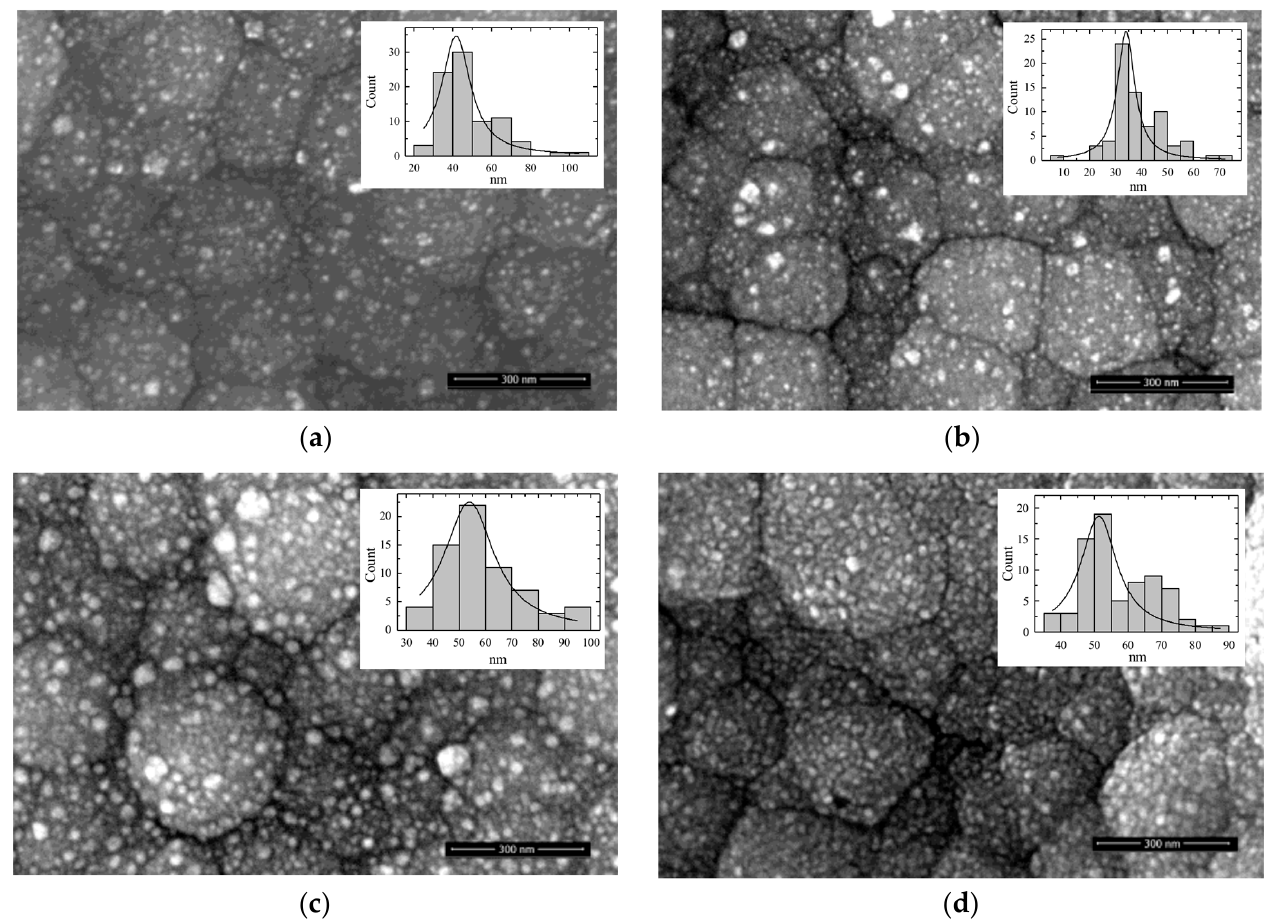
Figure 2. The surface morphology of: ( a – c ) AuNi-TiO 2 ntbs were fabricated by the dipping of TiO 2 ntb in the Ni plating solution operated at 85 °C for 5 s, followed by their dipping in Au-containing solution at 25 °C for ( a ) 60, ( b ) 300, and ( c ) 1800 s. ( d – f ) AuNi-TiO 2 ntb catalysts were fabricated by the dipping of TiO 2 ntb in the Ni plating solution operated at 85 °C for 20 s, followed by their dipping in the same Au plating solution at 25 °C for ( d ) 10, ( e ) 20, and ( f ) 60 s. The insets in ( d – f ) present the Au nanoparticle distribution.